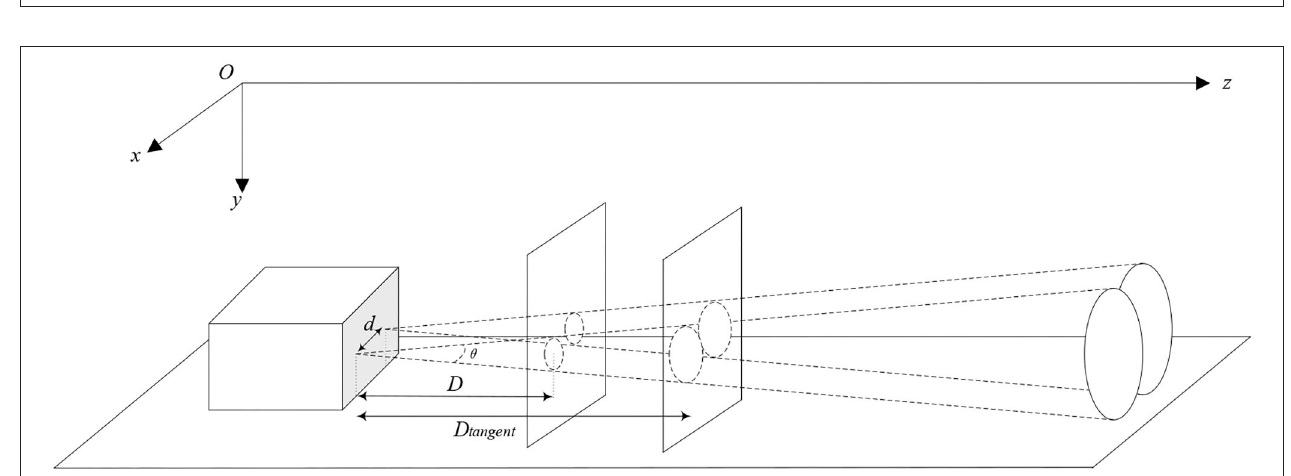
FIGURE 8 | Schematic diagram of the high beam light line